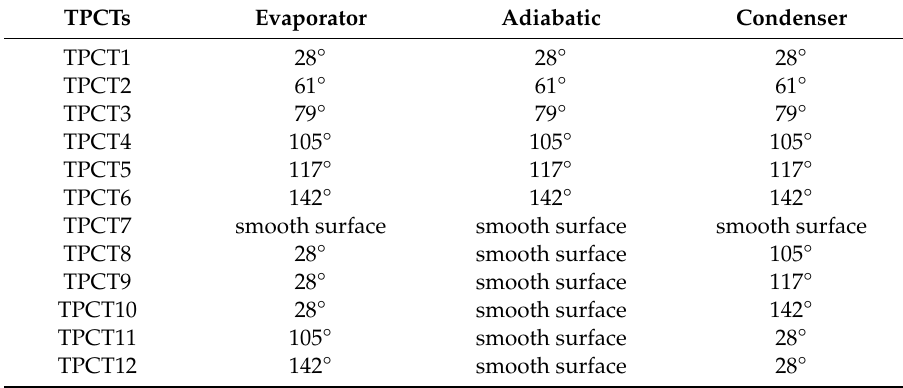
Table2. Di ff erenttwo-phaseclosedthermosyphons(TPCTs)oninnermodifiedsurfaceswithhydrophilic and hydrophobic